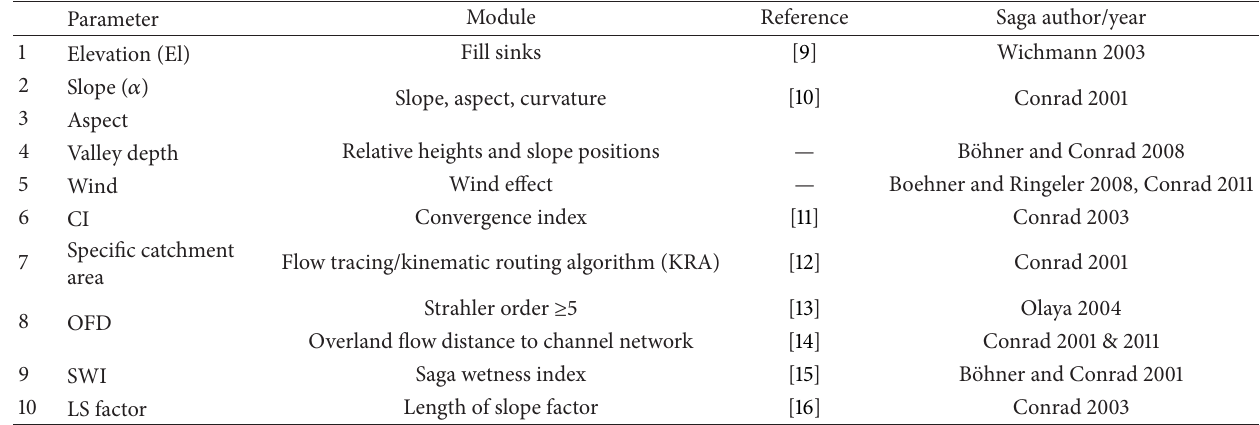
Table 1: Terrain parameter calculation with SAGA GIS